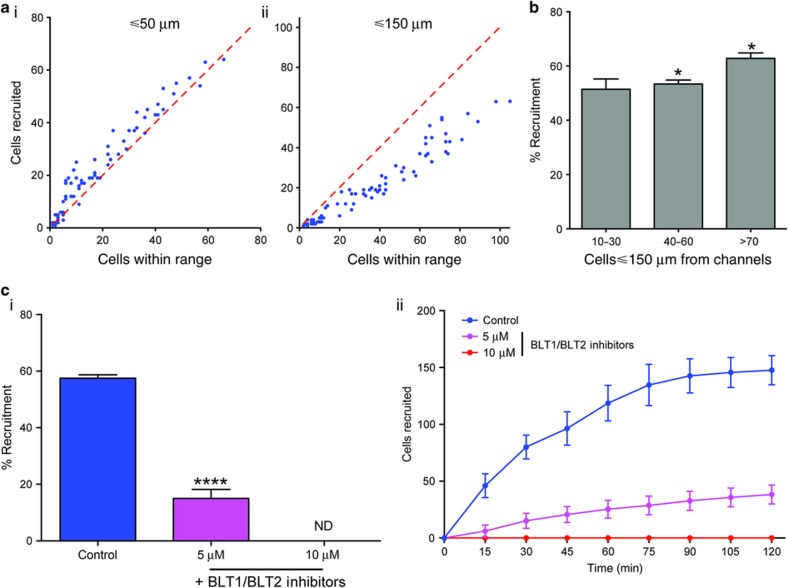
Long-range recruitment to formyl-methionyl leucyl-phenylalanine (fMLP) relies on LTB4 relay signaling. (a) Variation of neutrophil recruitment for cells within different ranges of the flow channel, within 50 μm (i) and 150 μm (ii) to the entrance of connecting channels (N=3. Each dot represents one reservoir and its vicinity). (b) Maximum neutrophil recruitment observed for different neutrophil densities in the flow channel within 150 μm to the entrance of connecting channels (Data collected from 75 reservoirs scored, pooled from N=5 experiments. Error bars=mean±standard error of the mean (s.e.m.), *p<0.05). (c) Treatment with inhibitors of the receptors for the neutrophil relay signal LTB4 significantly reduces overall recruitment (i) due to a consistent decrease in chemotaxis during the period scored (ii). (N=3. Error bars=mean±s.e.m.), ****p<0.001. Statistics: Normal one-way ANOVA with Tukey’s multiple comparisons test.